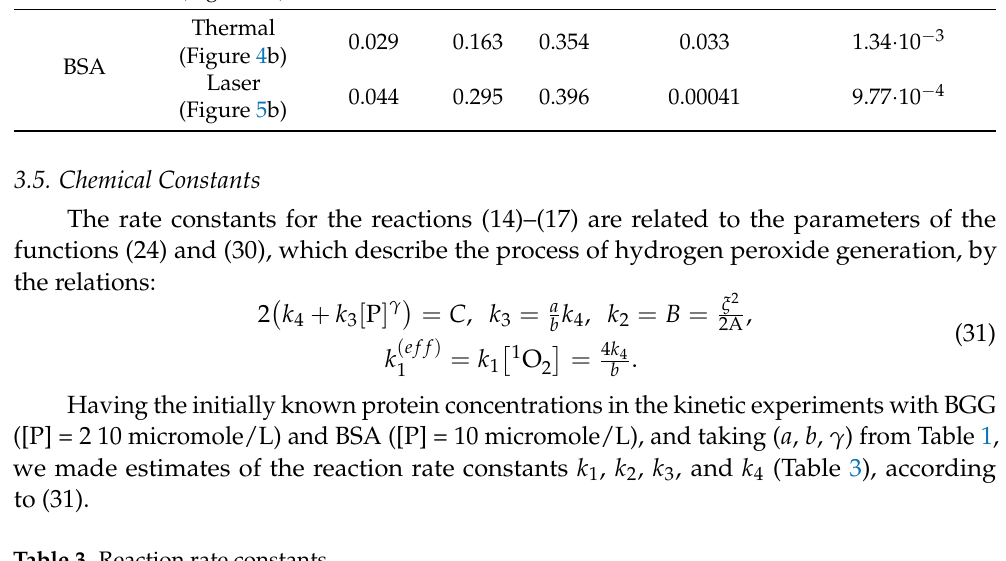
Table 3. Reaction rate